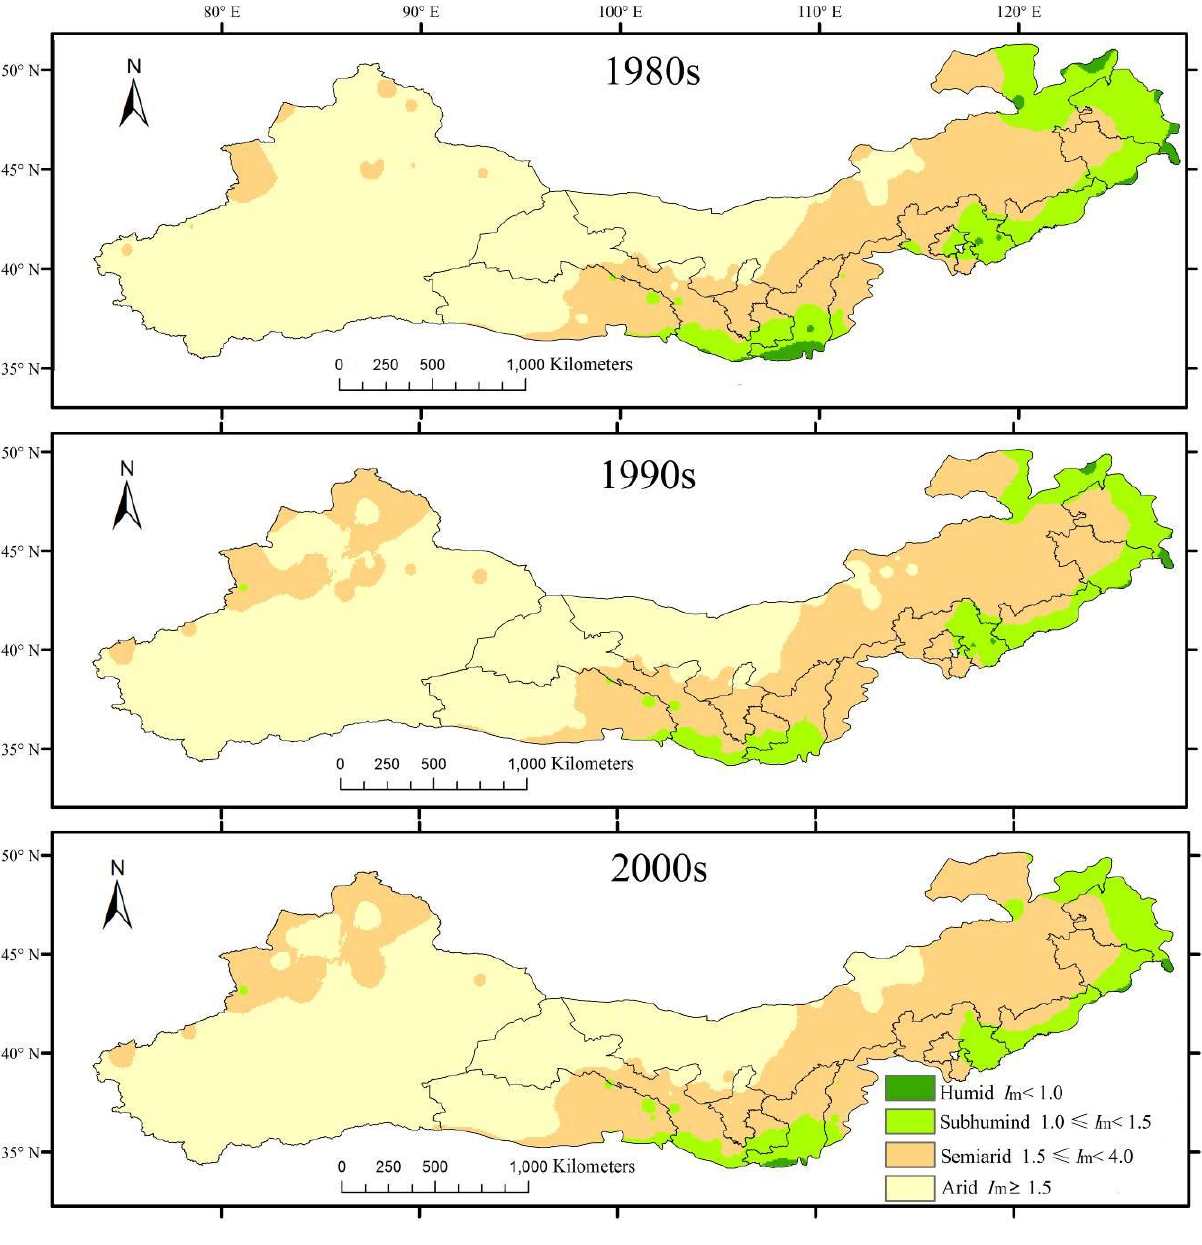
Figure 4. Spatio-temporal changes in different climate regions (1982–2011). Climate regions were defined and classified by Penman’s moisture index (Equation